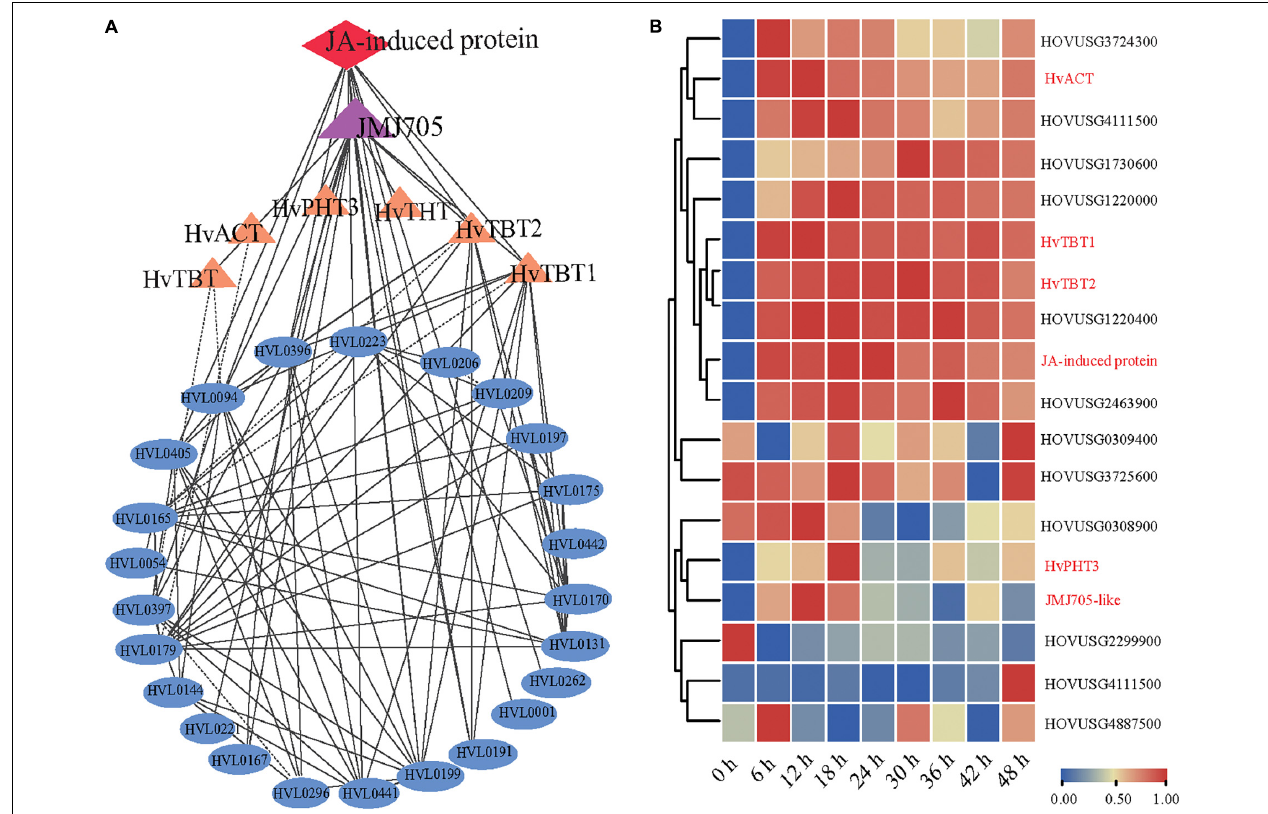
FIGURE 6 | JMJ705-like and JA-induced proteins are associated with the biosynthesis of PAs. (A) Co-expression network among PAs, N -acyltransferases, JMJ705 and JA-induced protein using cytoscape software. Metabolites, genes and protein were shown in oval, triangle and diamond, respectively. The lines indicate the value of correlation coefficient for each correlated pairs greater than 0.6. (B) Hierarchical clustering analysis of PAs pathway-related genes expression levels based on qRT-PCR data. The gene expression level per row was normalized to 0 to 1. Expression levels were analyzed by quantitative RT-PCR. HvACT : HOVUSG5340700 ; HvTBT1 : HOVUSG0308500; HvTBT2 : HOVUSG0309600 ; JA-induced protein : HOVUSG1730700 ; HvPHT3 : HOUSG2299900 ; JMJ705 - like : HOVUSG0811000 .